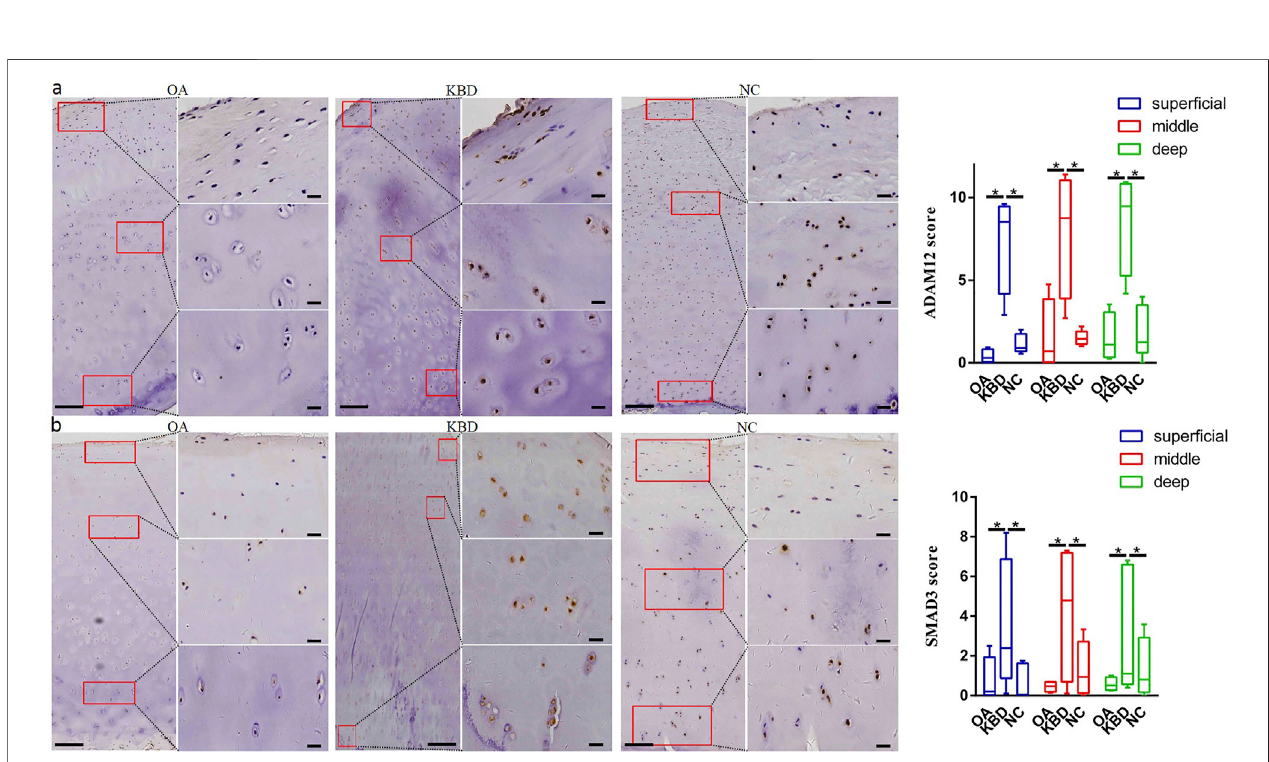
FIGURE 3 | Representative immunohistochemistry staining of ADAM12 (A) and SMAD3 (B) in OA, KBD, and normal control cartilage tissues. The scores of different areas (super fi cial, middle, and deep) in cartilage tissues displayed by box plot ( n (cid:1) 5). * p < 0.05.